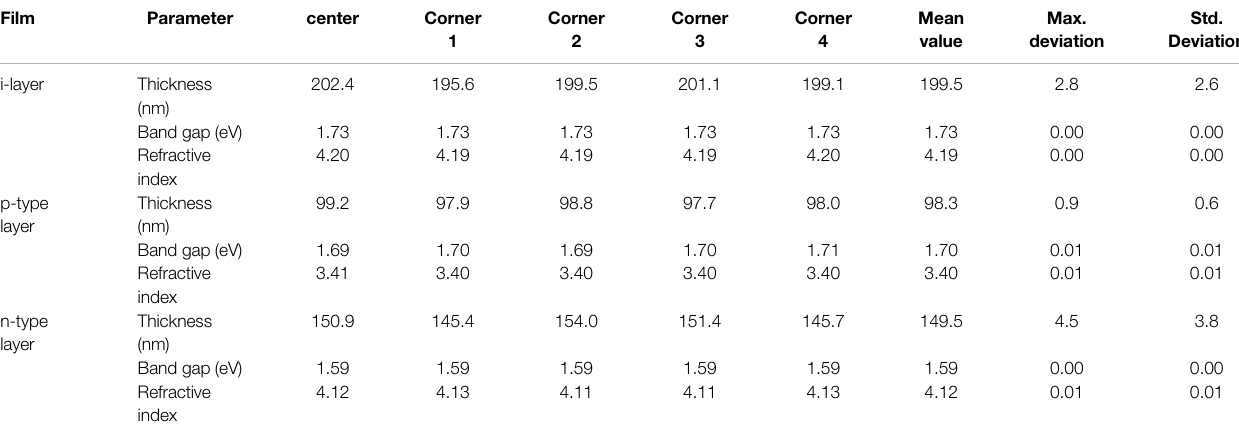
TABLE 3 | Variation of the optical parameters and thickness of the i, p, and n a-Si:H layers deposited by PECVD across the surface of the 20 cm 2 × 20 cm 2 substrate. Film